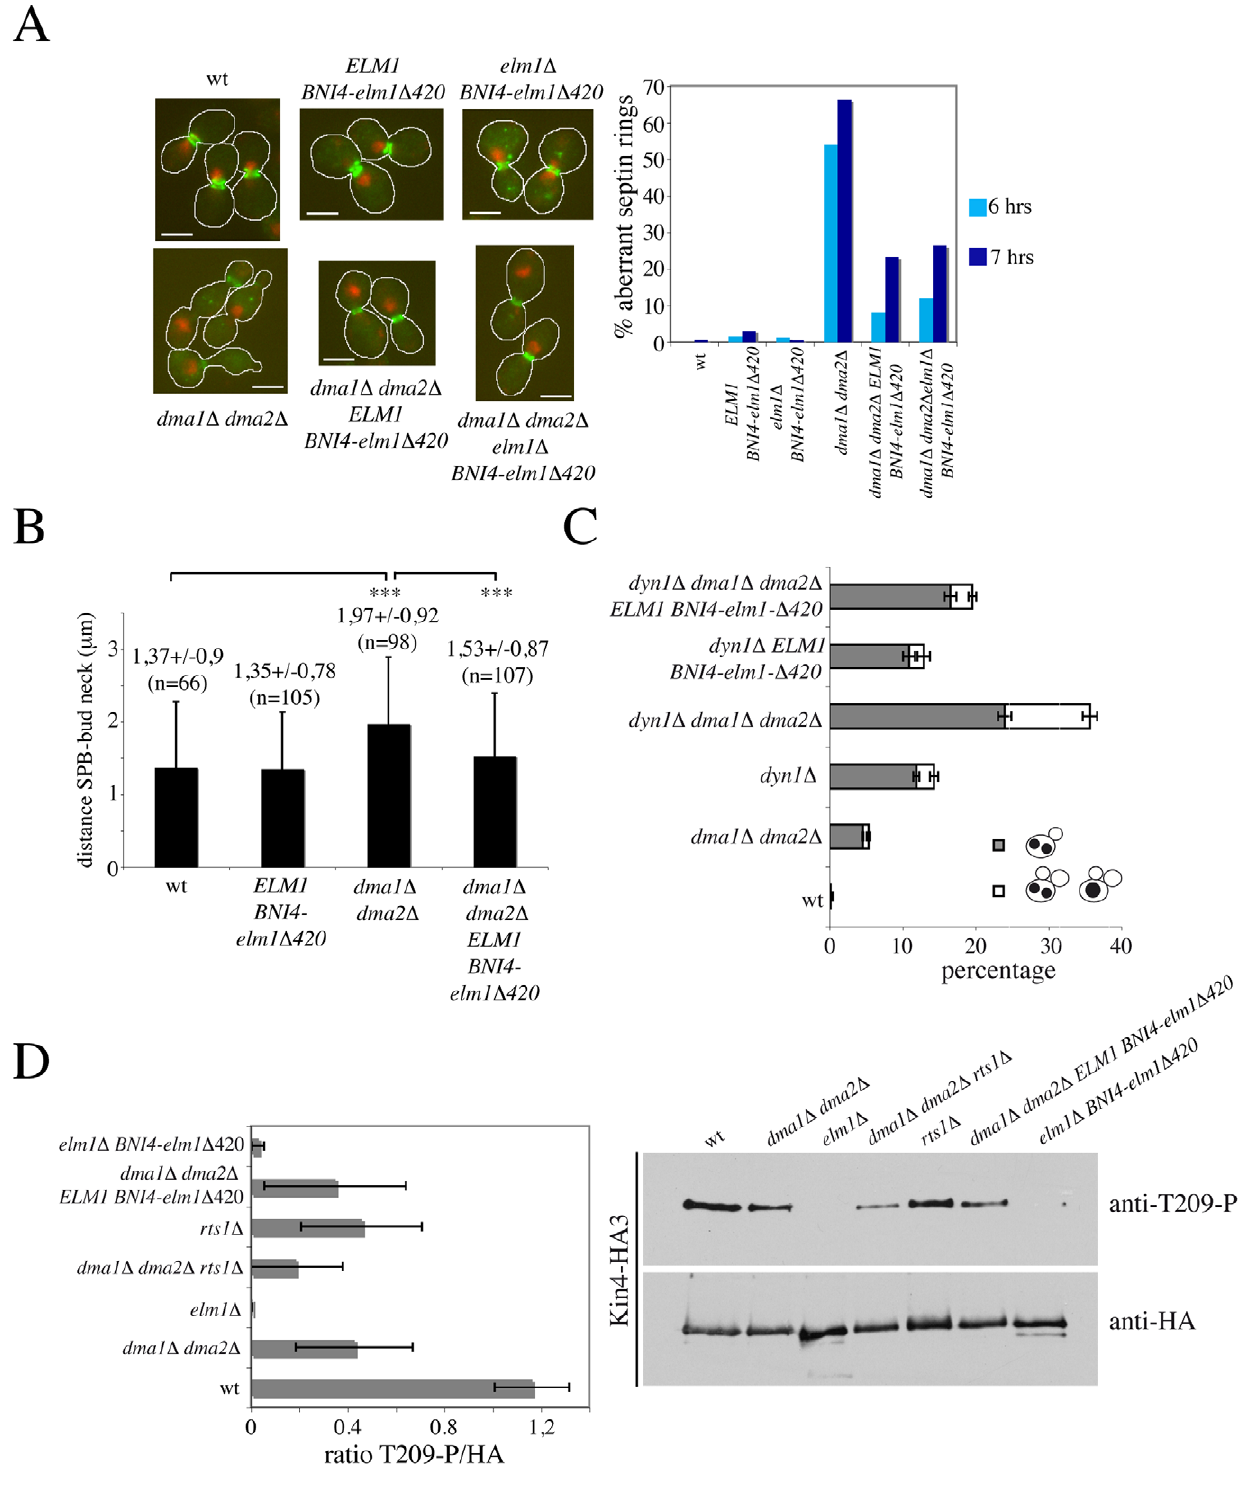
Figure 7. Restoring Elm1 localization at the bud neck of dma1 D dma2 D cells rescues their septin and SPOC defects without restoring Kin4 phosphorylation. A: Exponentially growing cultures of wild type (W303), dma1 D dma2 D (ySP1569), ELM1 BNI4-elm1 D 420 (ySP9589), elm1 D BNI4-elm1 D 420 (ySP9599), dma1 D dma2 D ELM1 BNI4-elm1 D 420 (ySP9587) and dma1 D dma2 D elm1 D BNI4-elm1 D 420 (ySP9588) were treated with HU at 25 u C and fixed after 6 and 7 hours to analyse the septin ring by in situ immunofluorescence with anti-Cdc11 antibodies. Representative micrographs were taken at t=7 hrs. Scale bars: 5 m m. B: Average SPB distance from the bud neck was measured in logarithmically growing wild type (ySP9594), dma1 D dma2 D (ySP9593), ELM1 BNI4-elm1 D 420 (ySP9636) and dma1 D dma2 D ELM1 BNI4-elm1 D 420 (ySP9634) strains expressing Spc42- mCherry to visualize the SPB. Only budded cells with two SPBs facing eachother in the mother cell were scored as indicative of a pre-anaphase stage and distances were measured from the most proximal SPB to the bud neck. ***: p , 0,001, t -test. C: wild type (W303), dma1 D dma2 D (ySP1569), dyn1 D